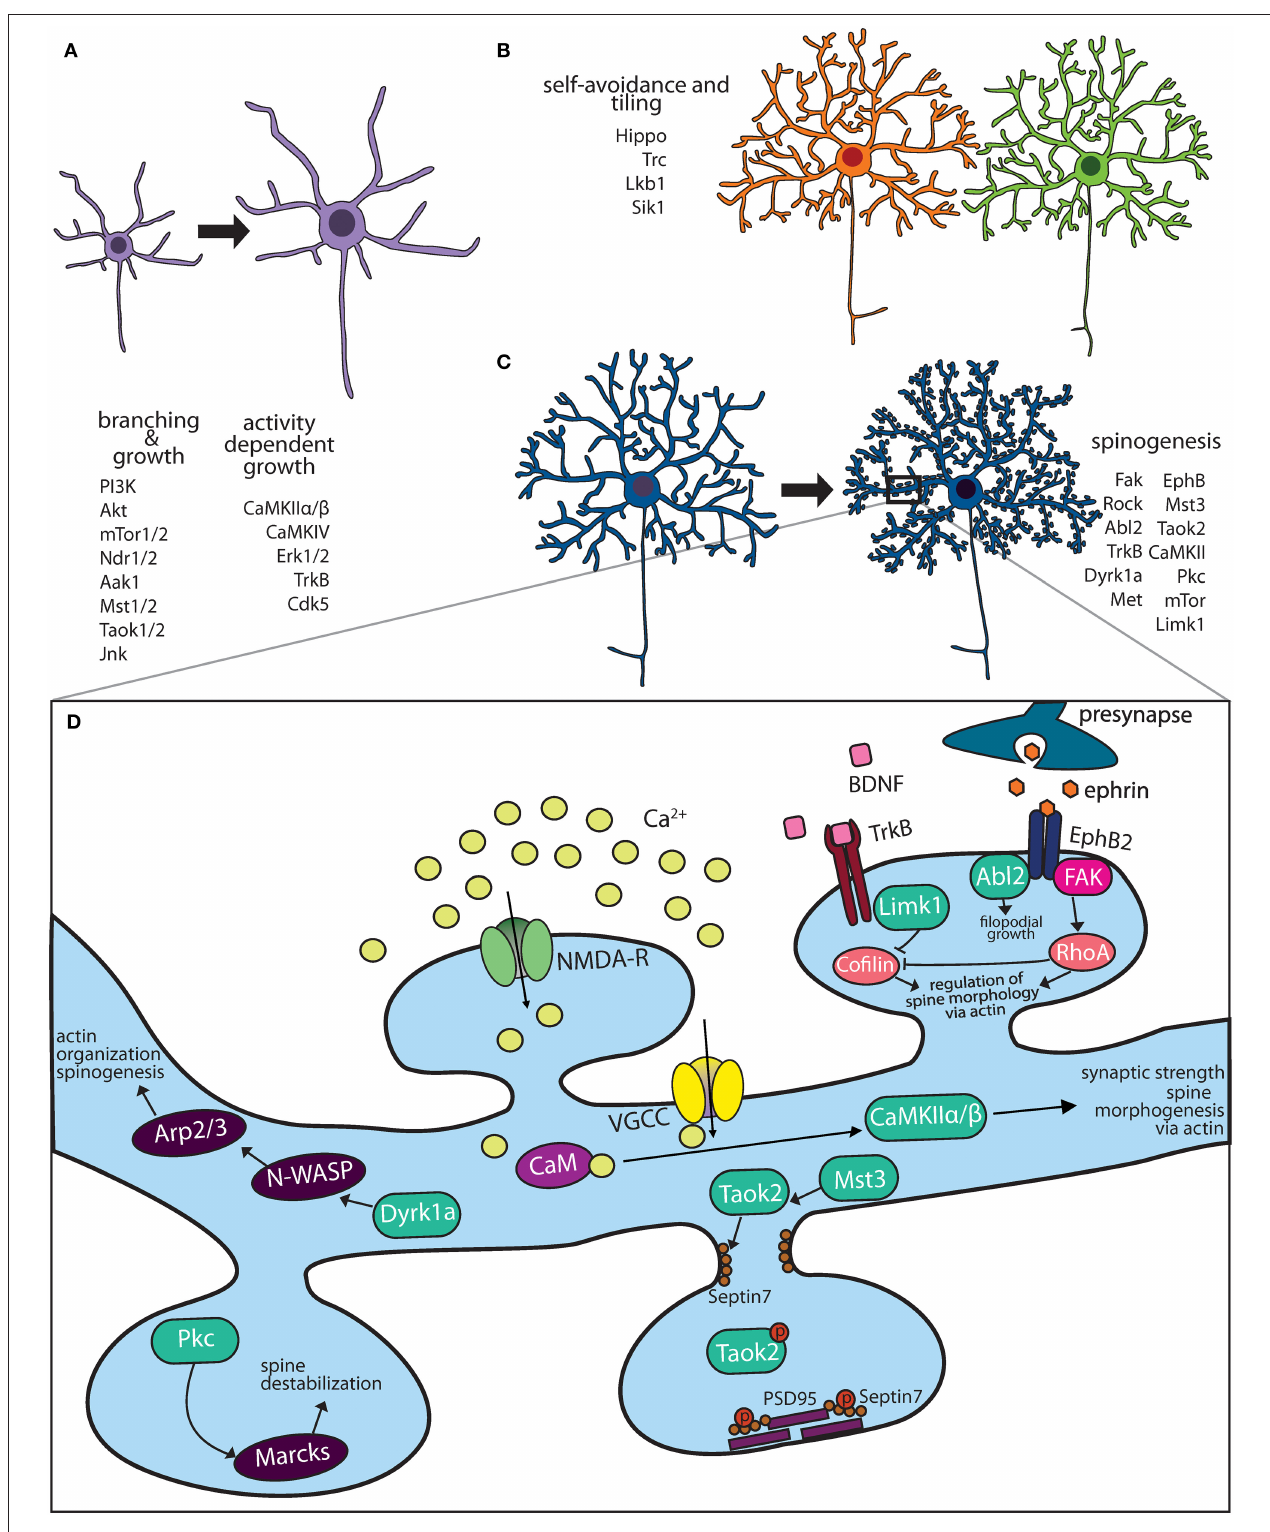
FIGURE 1 | Kinase pathways mediate dendritic morphogenesis and maturation. (A) Immature dendritic neurites undergo expansive growth and branching during early development. The PI3K-Akt-mTor kinase and Hippo pathway are critical for growth. Activity dependent growth is primarily mediated by Ca + 2 influx and downstream signaling by CaMK family members. (B) During arborization, dendrites of the same neuron avoid overlap through a principle known as self-avoidance,